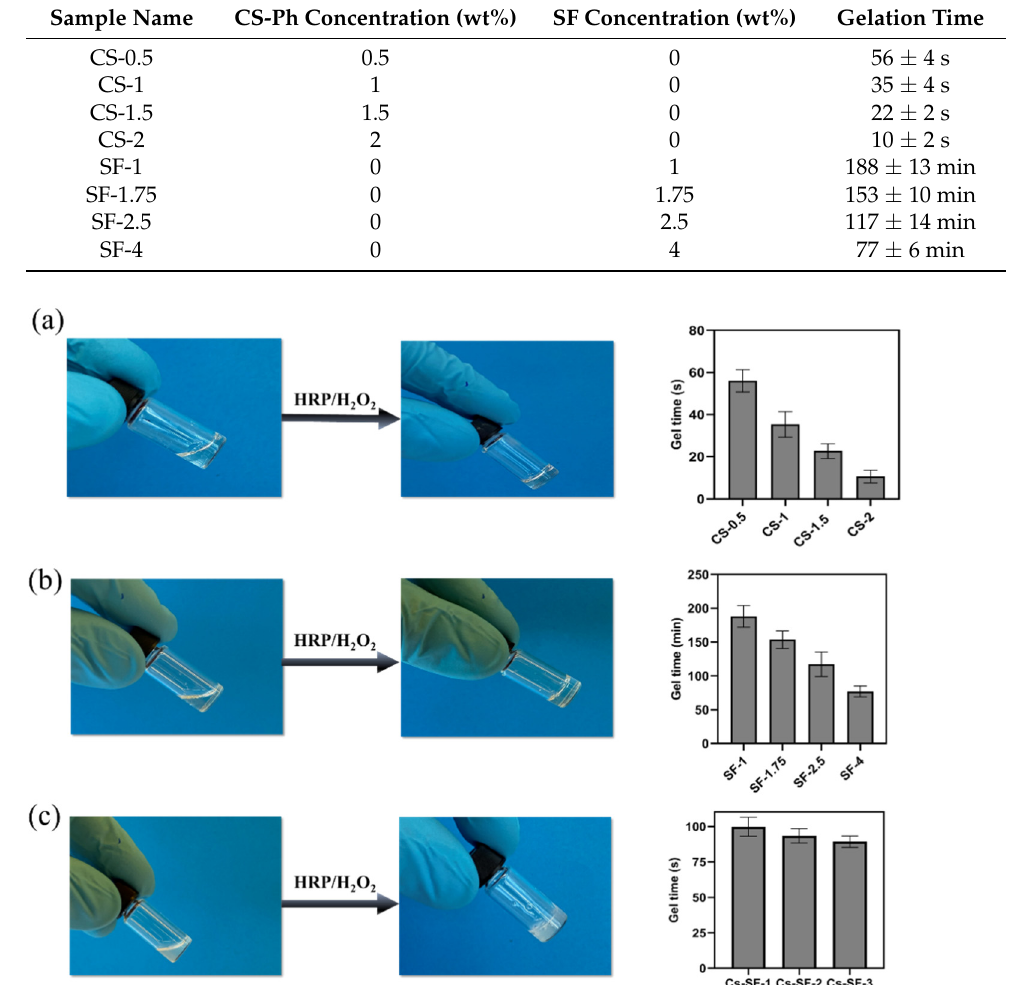
Figure 2. Pictures of sol–gel transition and gel time of the hydrogels: ( a ) Cs, ( b ) SF, ( c ) Cs-SF